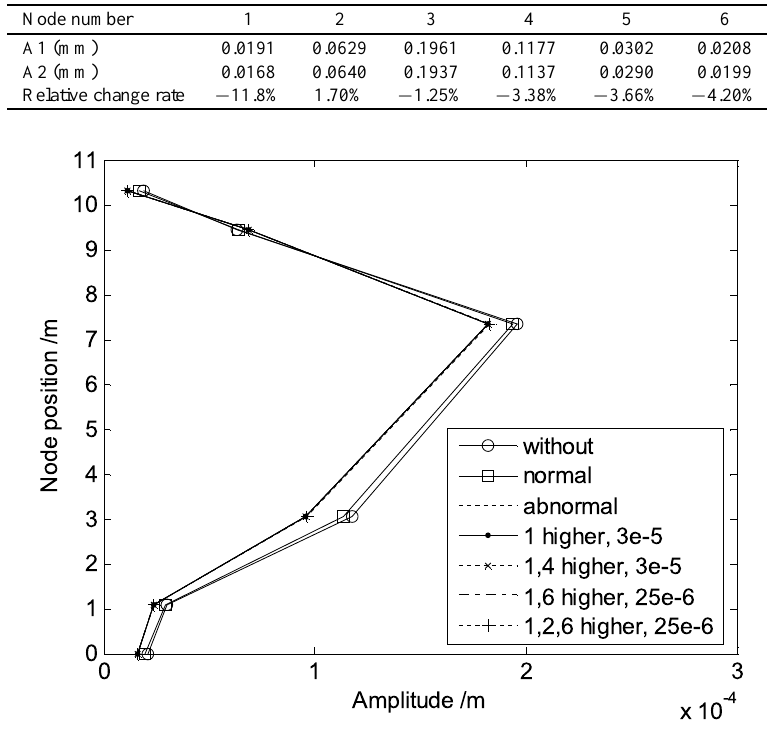
Fig. 7. Amplitudes of lateral shaft vibration with different